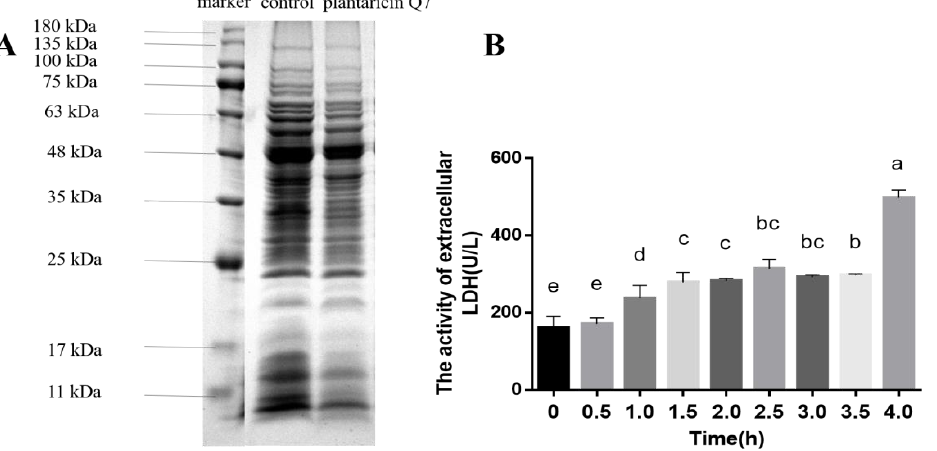
Figure 3. Effects of plantaricin Q7 on intracellular substances leakage of L. monocytogenes . ( A ) Effect of plantaricin Q7 on L. monocytogenes cell protein. ( B ) Effects of plantaricin Q7 on LDH activity. The data were shown as mean ± SD ( n = 3). Different letters in the figure denoted significant statistical differences ( p < 0.05).